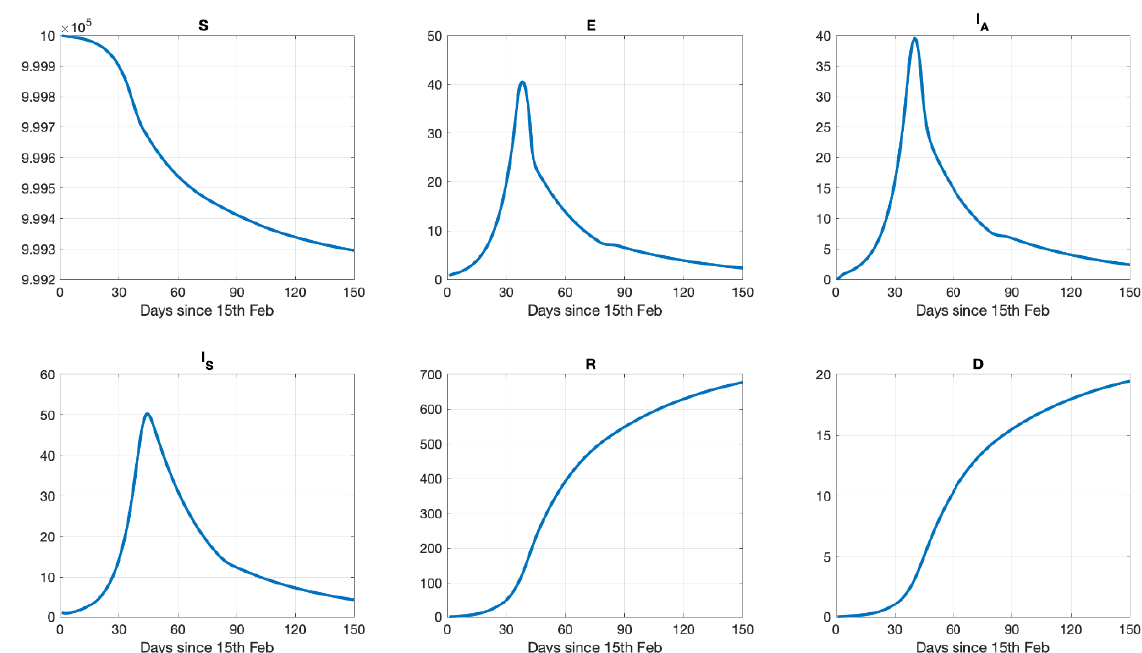
Figure 5. Model population dynamics (per million) with the optimal configuration for Susceptibles (S) , Exposed individuals (E) , Asymptomatic infected individuals (I A ) , Infected individuals with symptomatics (I S ) , Recovered (R) , Dead (D) .